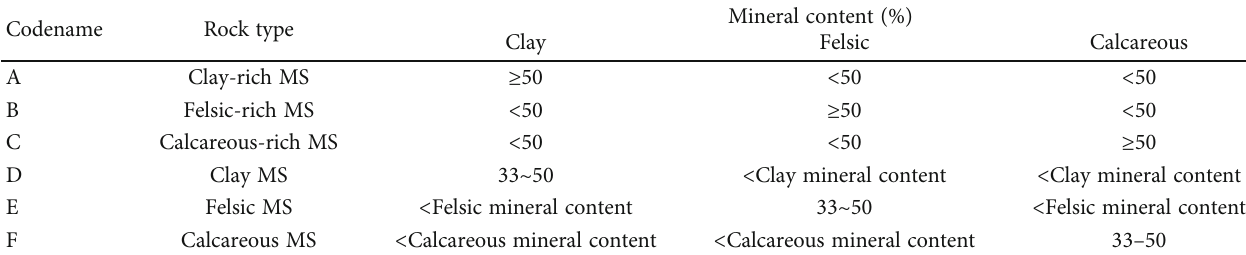
Table 1: Classi fi cation of rock types in the Es 1L of the Raoyang